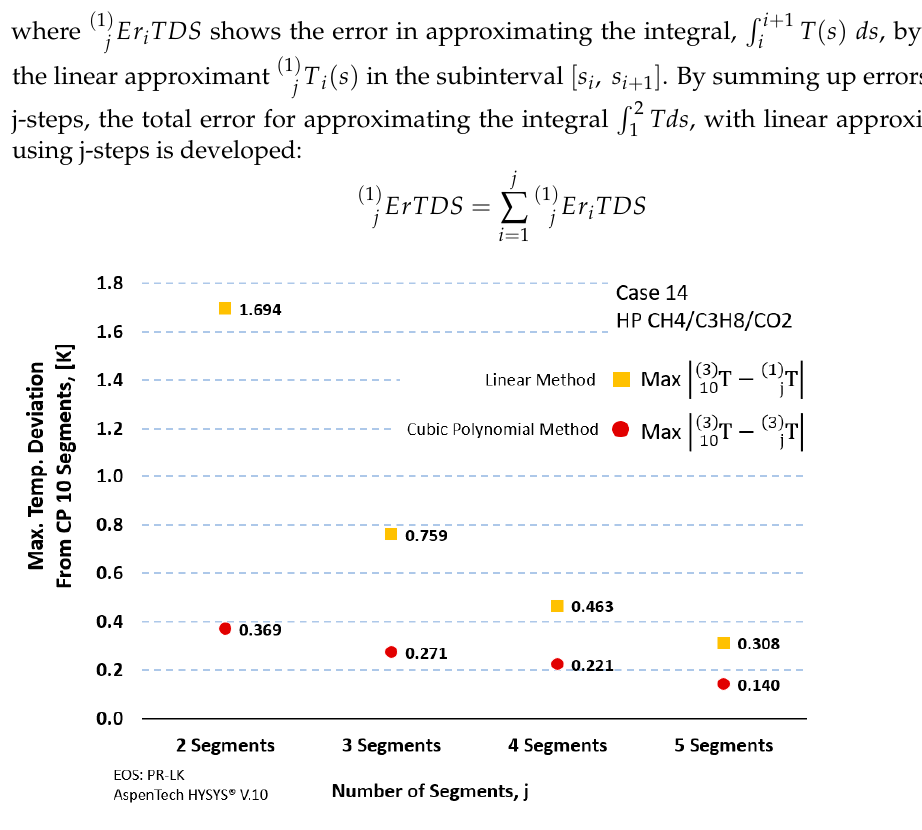
Figure 7. Maximum temperature deviation along the polytropic path for the example case 14. See Table A1 in Appendix B for gas compositions and compressor inlet and discharge conditions.